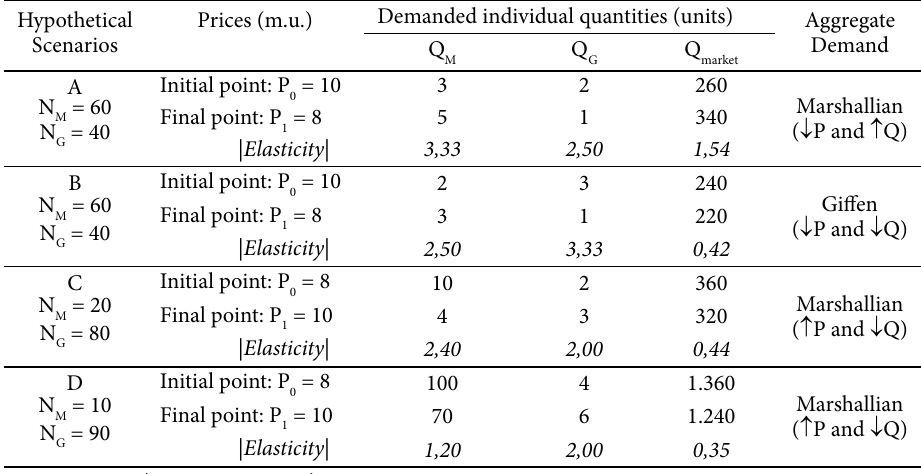
Table 5. The phenomenon of concealed Giffen Demand Hypothetical Prices Scenarios